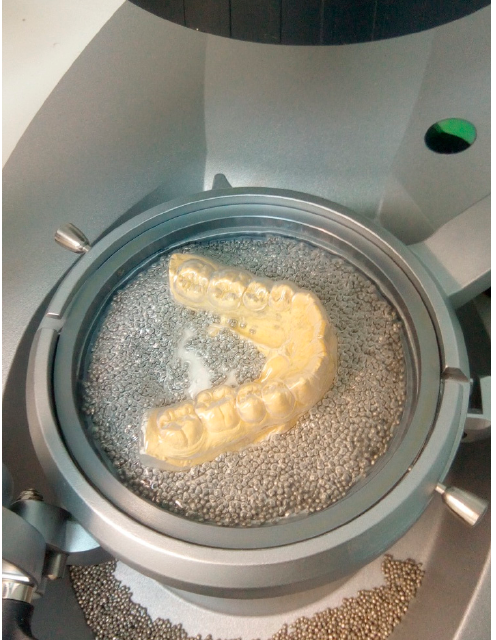
Figure 2. First lamination with 2 mm EVA foil.